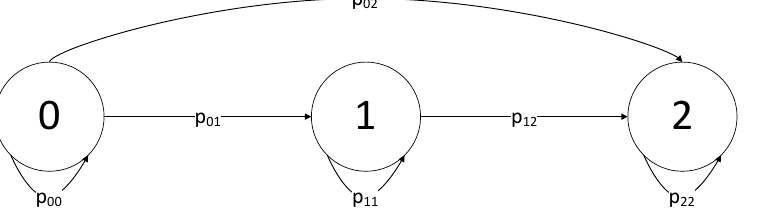
Figure 2. Markov chain with state space E = { 0,1, . . . l = 2 } . Each state corresponds to the number of distinct nodes that exist in the pool of known nodes of the client, e.g., state 1 means we found 1 out of 2